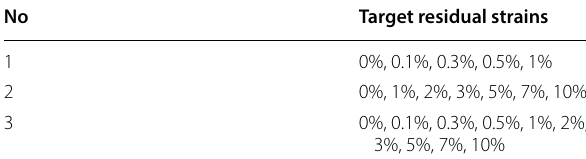
Table 1 Target residual strain for history